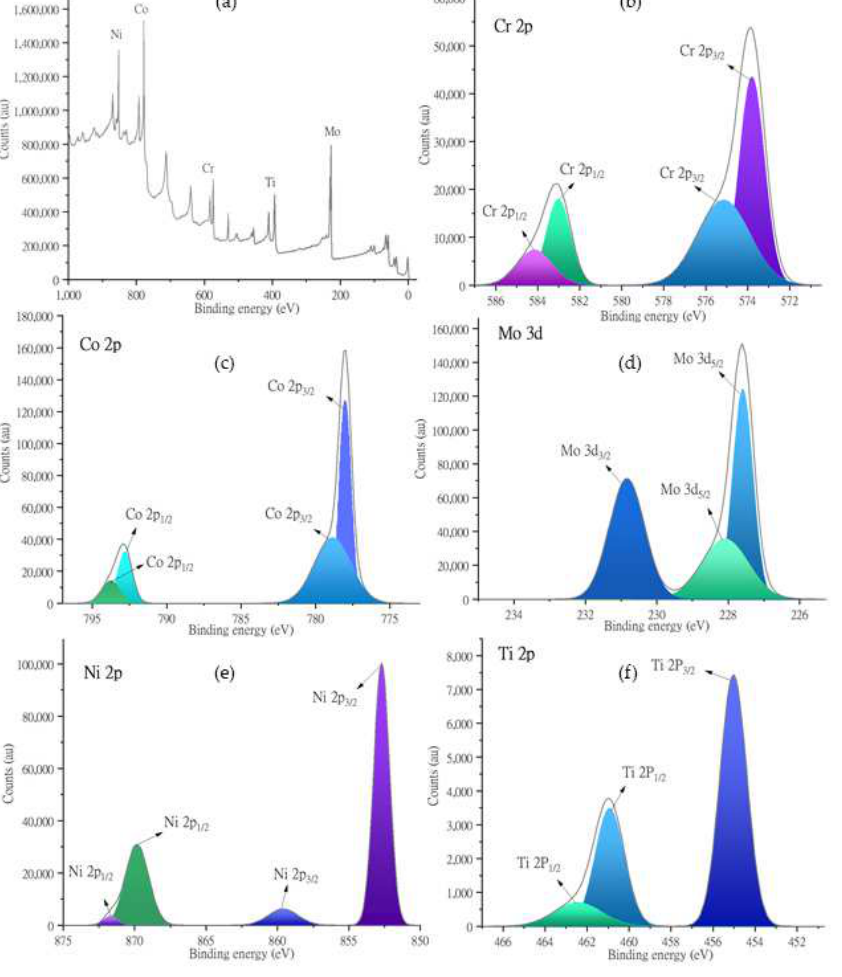
Figure 4. ( a ) XPS analysis of Co 30 Cr 20 Ni 20 Mo 20 Ti 10 HEA-synthesized through magnetron sputtering and the corresponding peak fitting of ( b ) chromium, ( c ) cobalt, ( d ) molybdenum, ( e ) nickel, and ( f ) titanium. ( f )